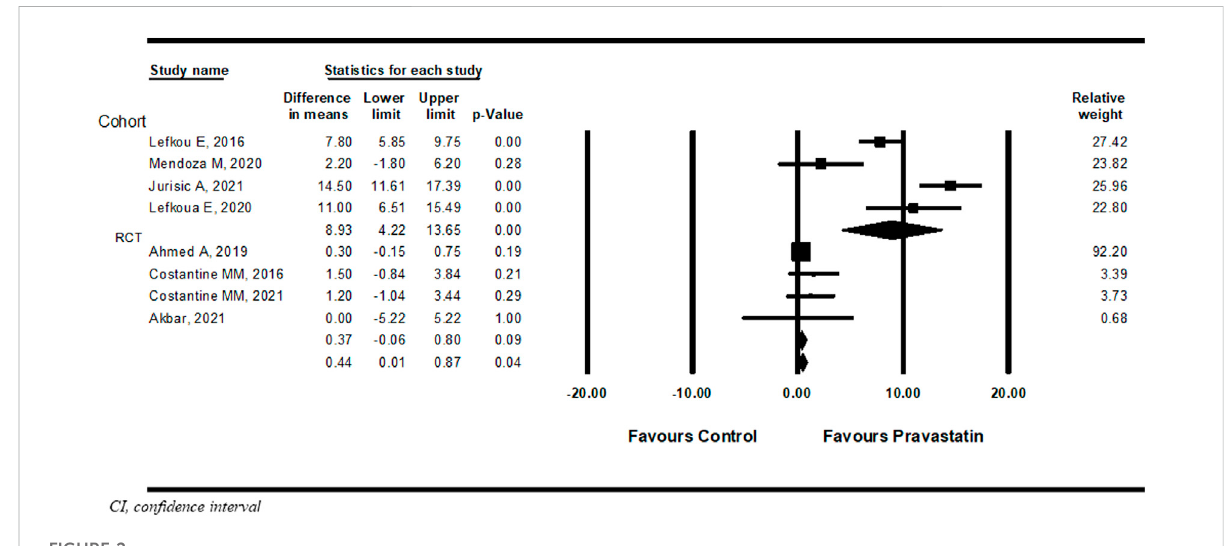
FIGURE 3 Meta-analysis results of the association of pravastatin treatment with admission to the neonatal intensive care unit.